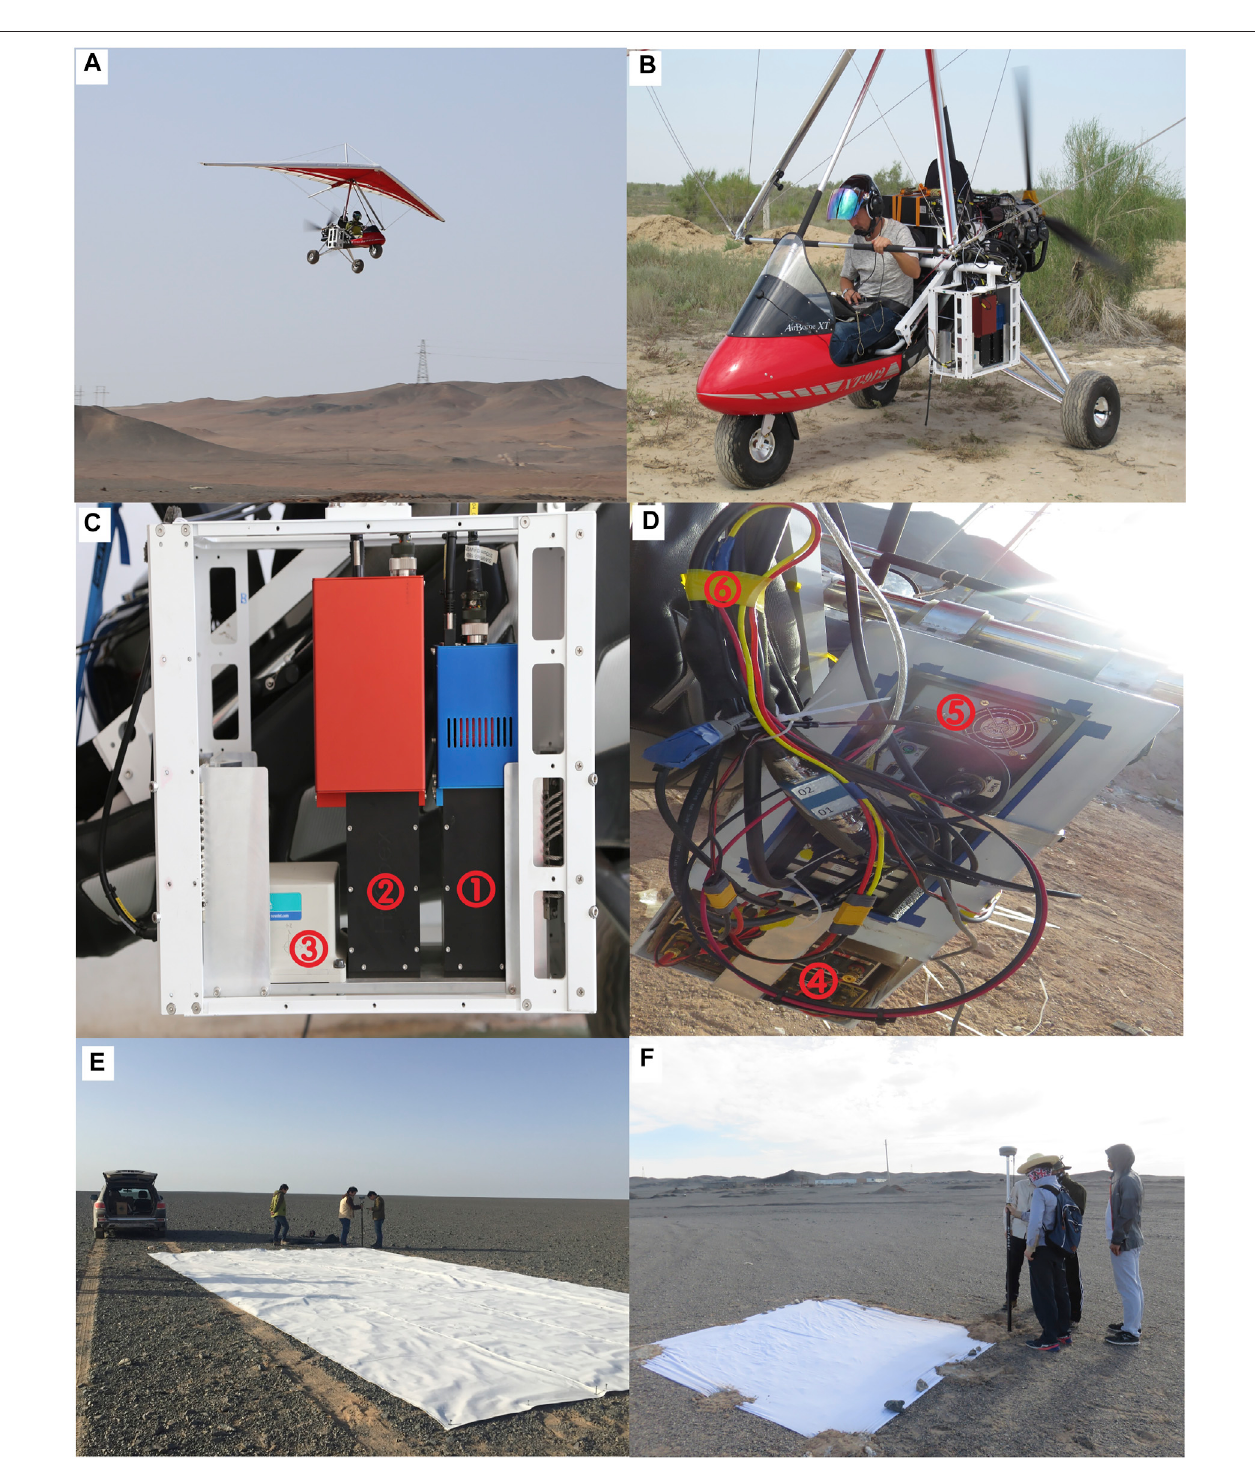
FIGURE 2 | Photographs of the HySpex system for airborne acquisition. (A) Delta wing XT-912 aircraft, (B) HySpex sensors in aircraft, (C) HySpex sensors assembly, (D) main computer assembly, (E) 4 m × 4 m white reference panel, and (F) a geographical reference correction point. Details of HySpex sensors and computerassembly: ① HySpexVNIRsensor(Sensor1), ② HySpexSWIRsensor(Sensor2), ③ inertialnavigationset, ④ batterypack, ⑤ maincomputercase, ⑥ air-to- ground communication equipment and cables.